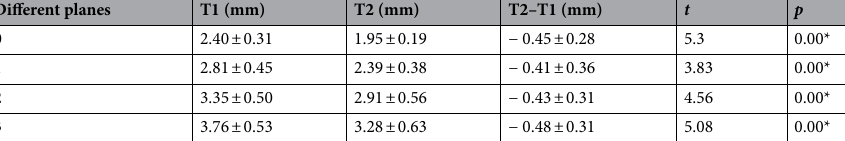
Table 3. The bone gain and resorption of the the xenogeneic bone ring around the implants in the study. Different planes: different parallel planes below the implant neck platform (mm); T1: Immediate postoperative; T2:12 months after prosthetic restorations. p*: p <